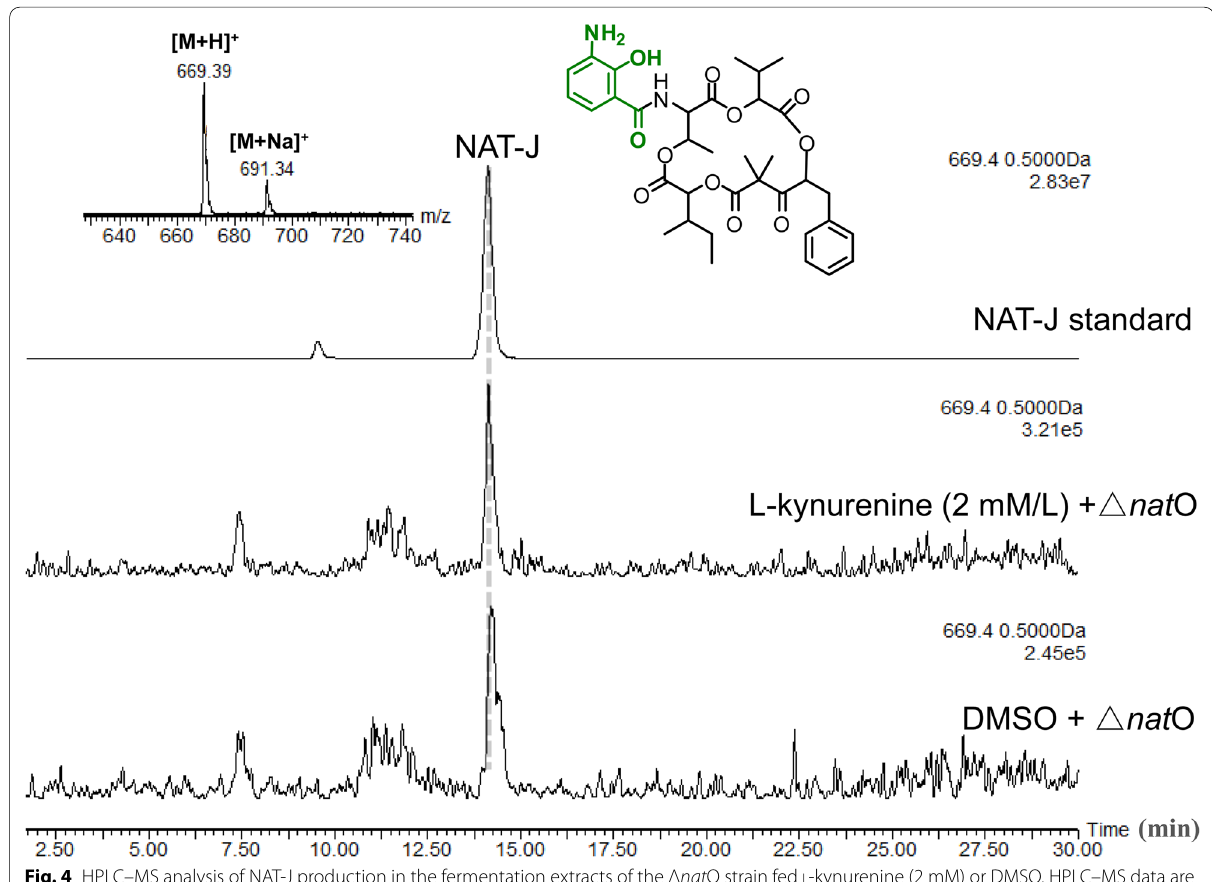
Fig. 4 HPLC–MS analysis of NAT‑J production in the fermentation extracts of the Δ nat O strain fed l ‑kynurenine (2 mM) or DMSO. HPLC–MS data are displayed with the mass extraction of [M H] + m / z 669.4 for +